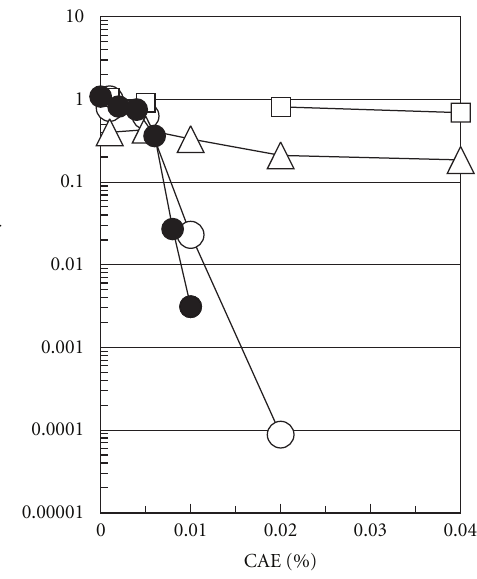
Figure 4: Inactivation of viruses by CAE. The viruses were incubated at 20 ◦ C for 5min in 10 mM citrate bu ff er (pH 5.0) containing 0.15 M sodium chloride and varying concentrations of CAE. Number of infectious virus was determined by a plaque assay after the incubation and was normalized to that incubated in PBS (pH 7.4). Circles ( (cid:4) ) for HSV-1; black circle ( • ) for HSV-2; triangles ( (cid:5) ) for IAV; squares ( (cid:2) ) for